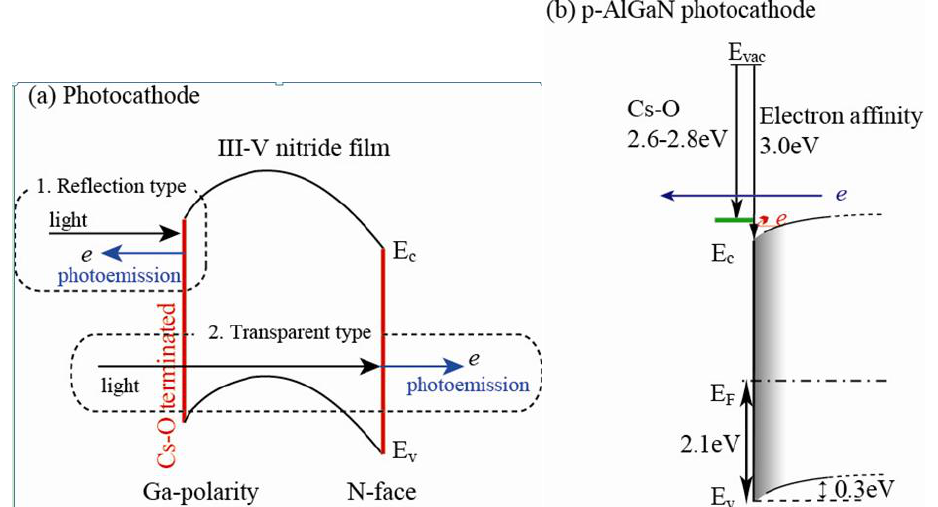
Figure 7. ( a ) Schematic illustration of band diagram to explain reflection and transparent type photocathode device in case of III-V nitride semiconductor. ( b ) Band diagram of p-AlGaNfrom the band-bending value and position of VBM evaluated by hard X-ray photoemission spectroscopy at